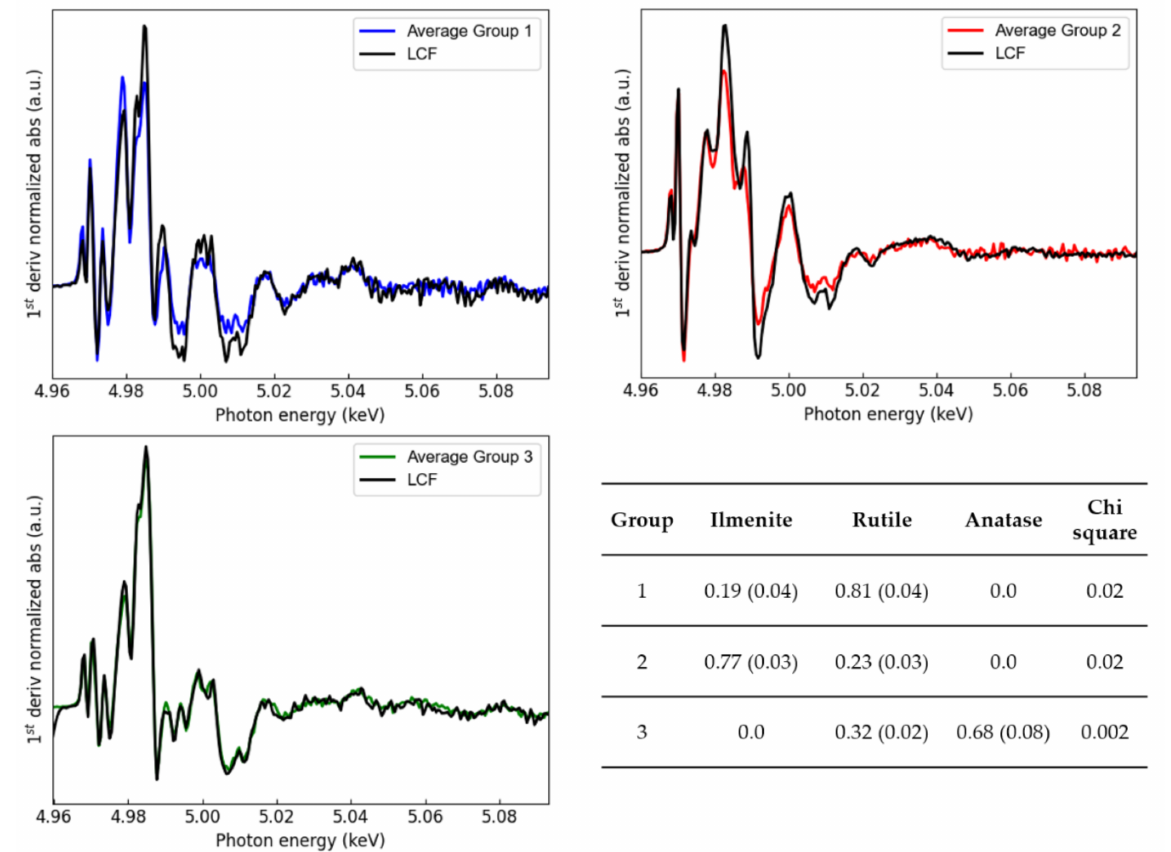
Figure A5. Linear combination fitting (LCF) of groups of spectra obtained by PCA analysis. The LCF was performed in first derivative to maintain consistency with the PCA model. Anatase and rutile references were measured at ID21, ESRF. Ilmenite reference was obtained from XAS database of the beamline 10.3.2 at the Advanced Light Source, Berkeley, CA,